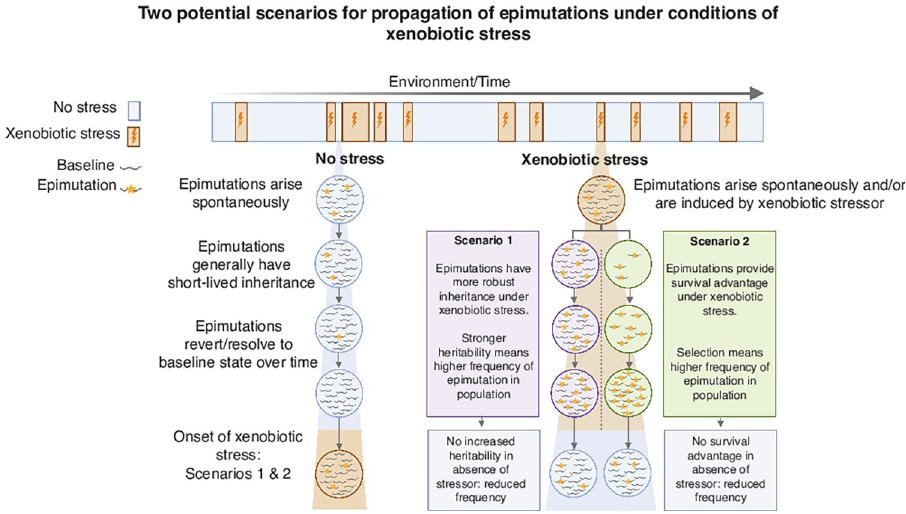
Fig 7. Two potential mechanisms for propagation of spontaneous epimutations under xenobiotic stress. We propose two scenarios whereby epimutations may be propagated with short term reversibility under conditions of xenobiotic stress and the potential for adaptive